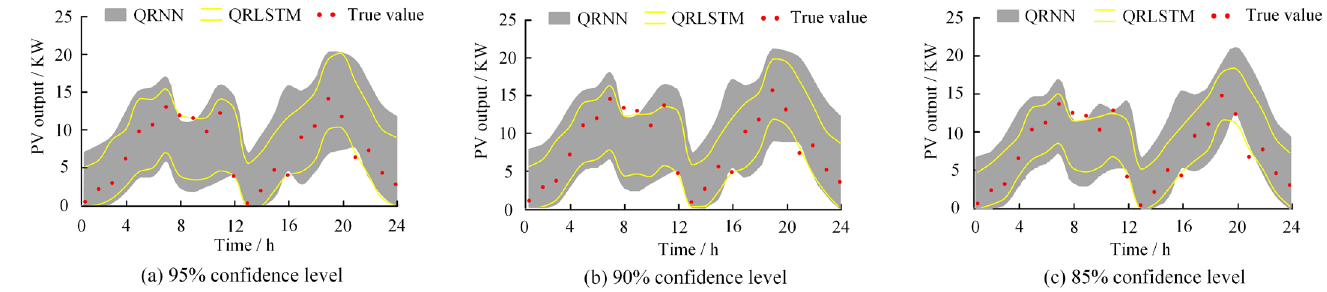
Figure 7. Comparison of interval prediction results on similar-day 3.